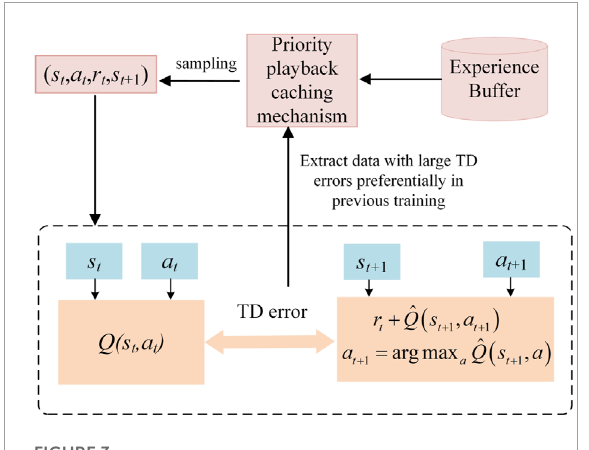
FIGURE 3 Schematic diagram of priority playback caching